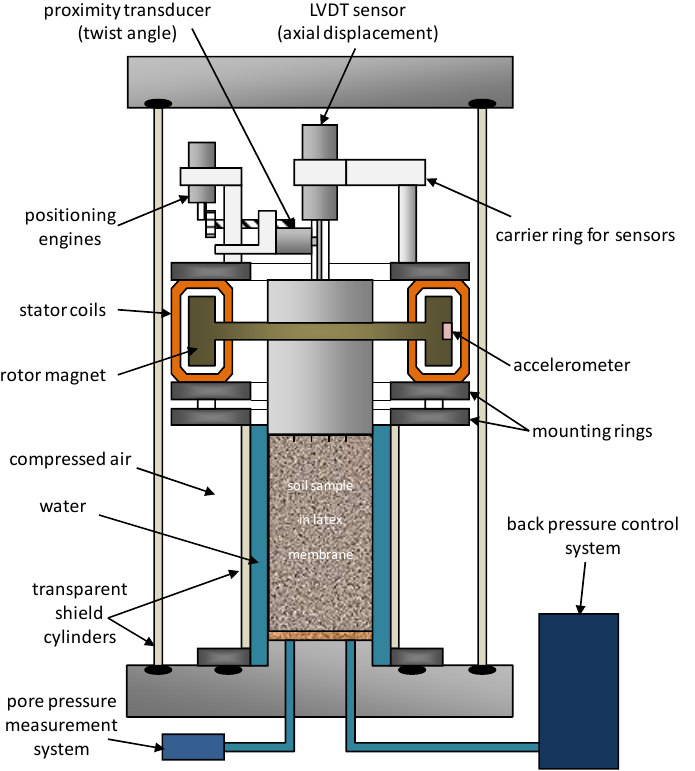
Figure 4. Components of RC/TS apparatus [40].